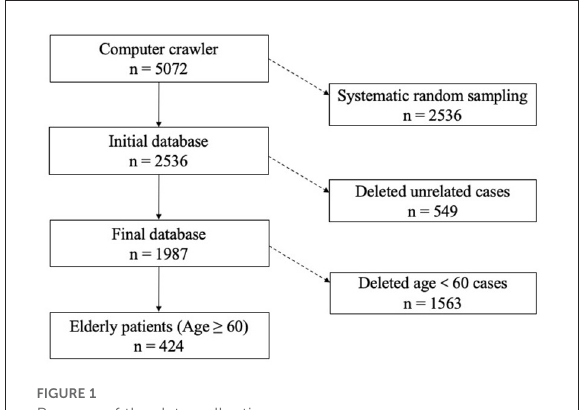
FIGURE1 Process of the data